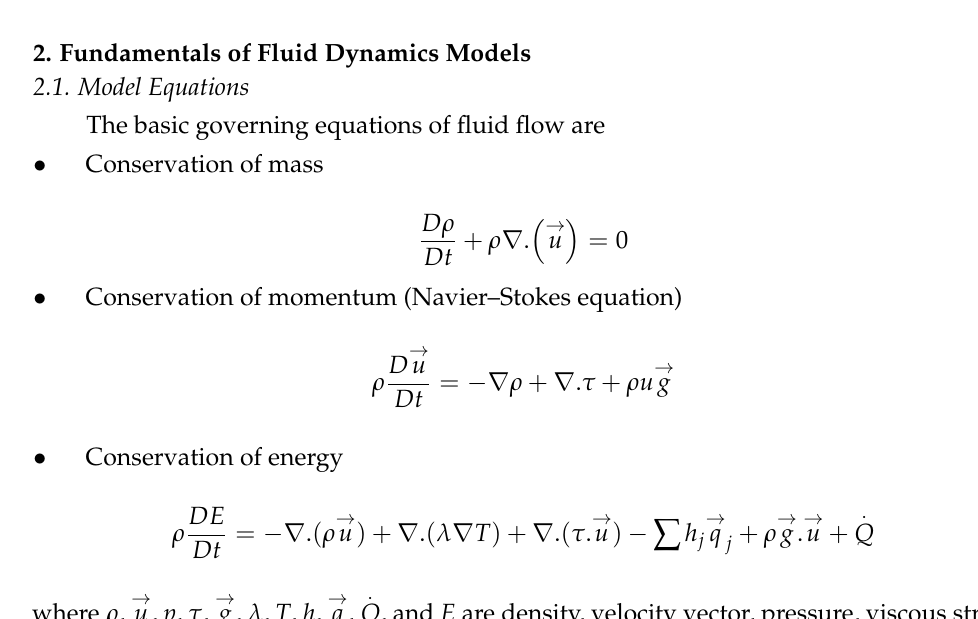
Figure 2. Illustration of wind pressure distribution on a house from CFD simulation with the left inlet wind velocity set to 3